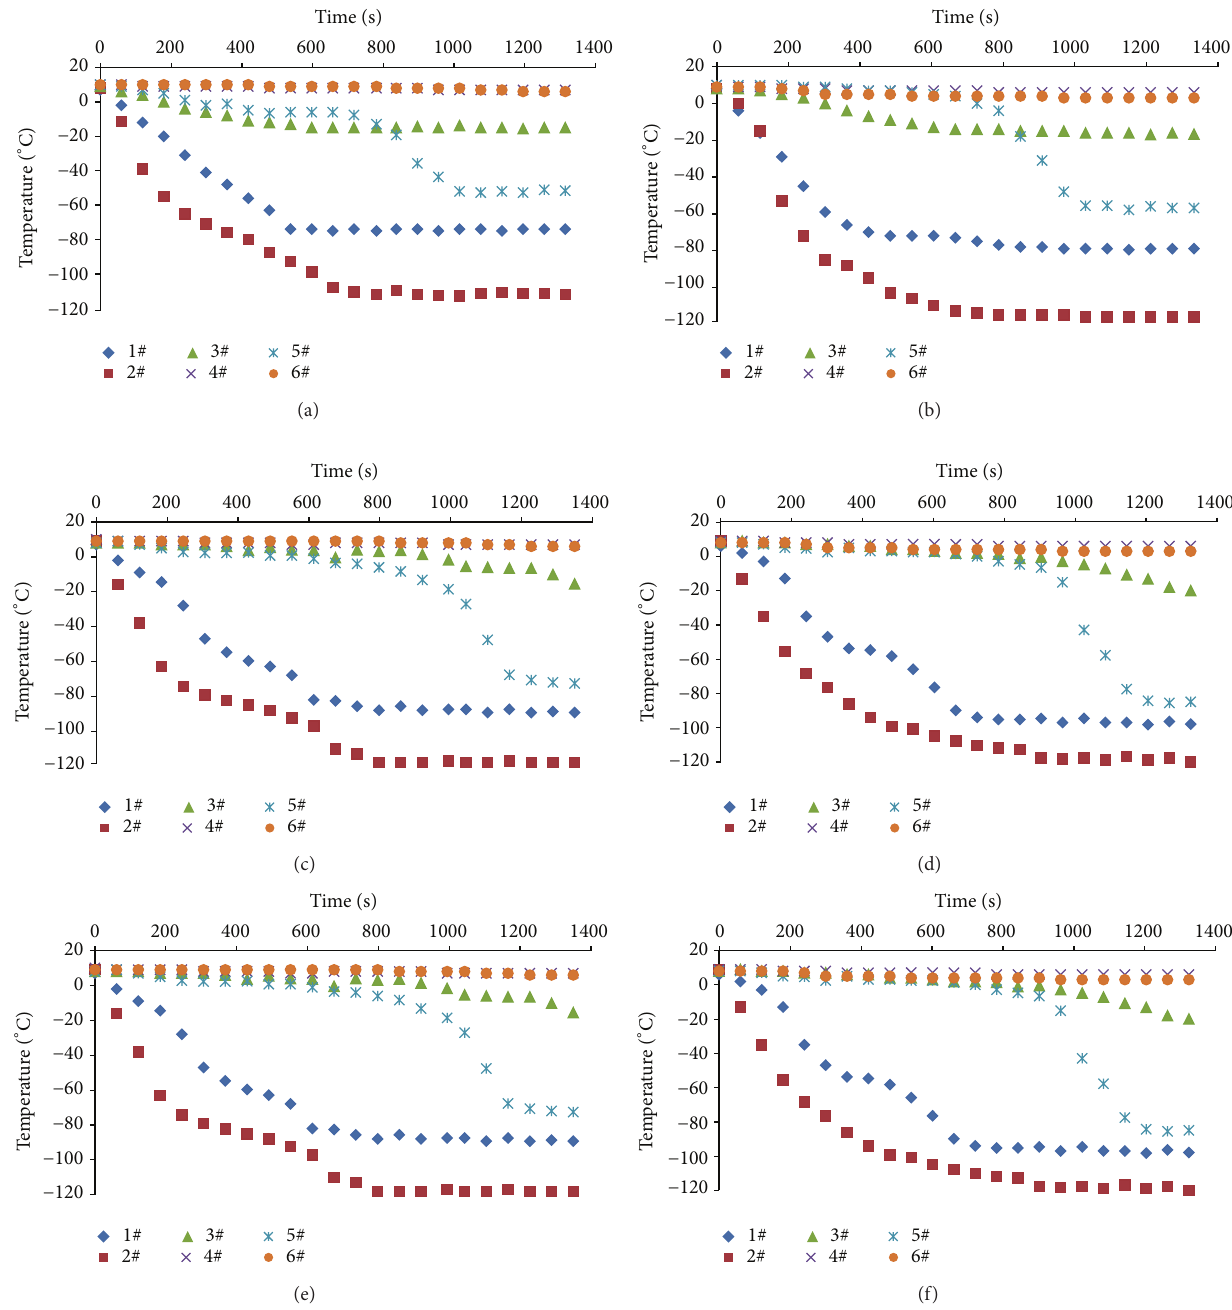
Figure 2: Temperature variation of measuring points dependent on the